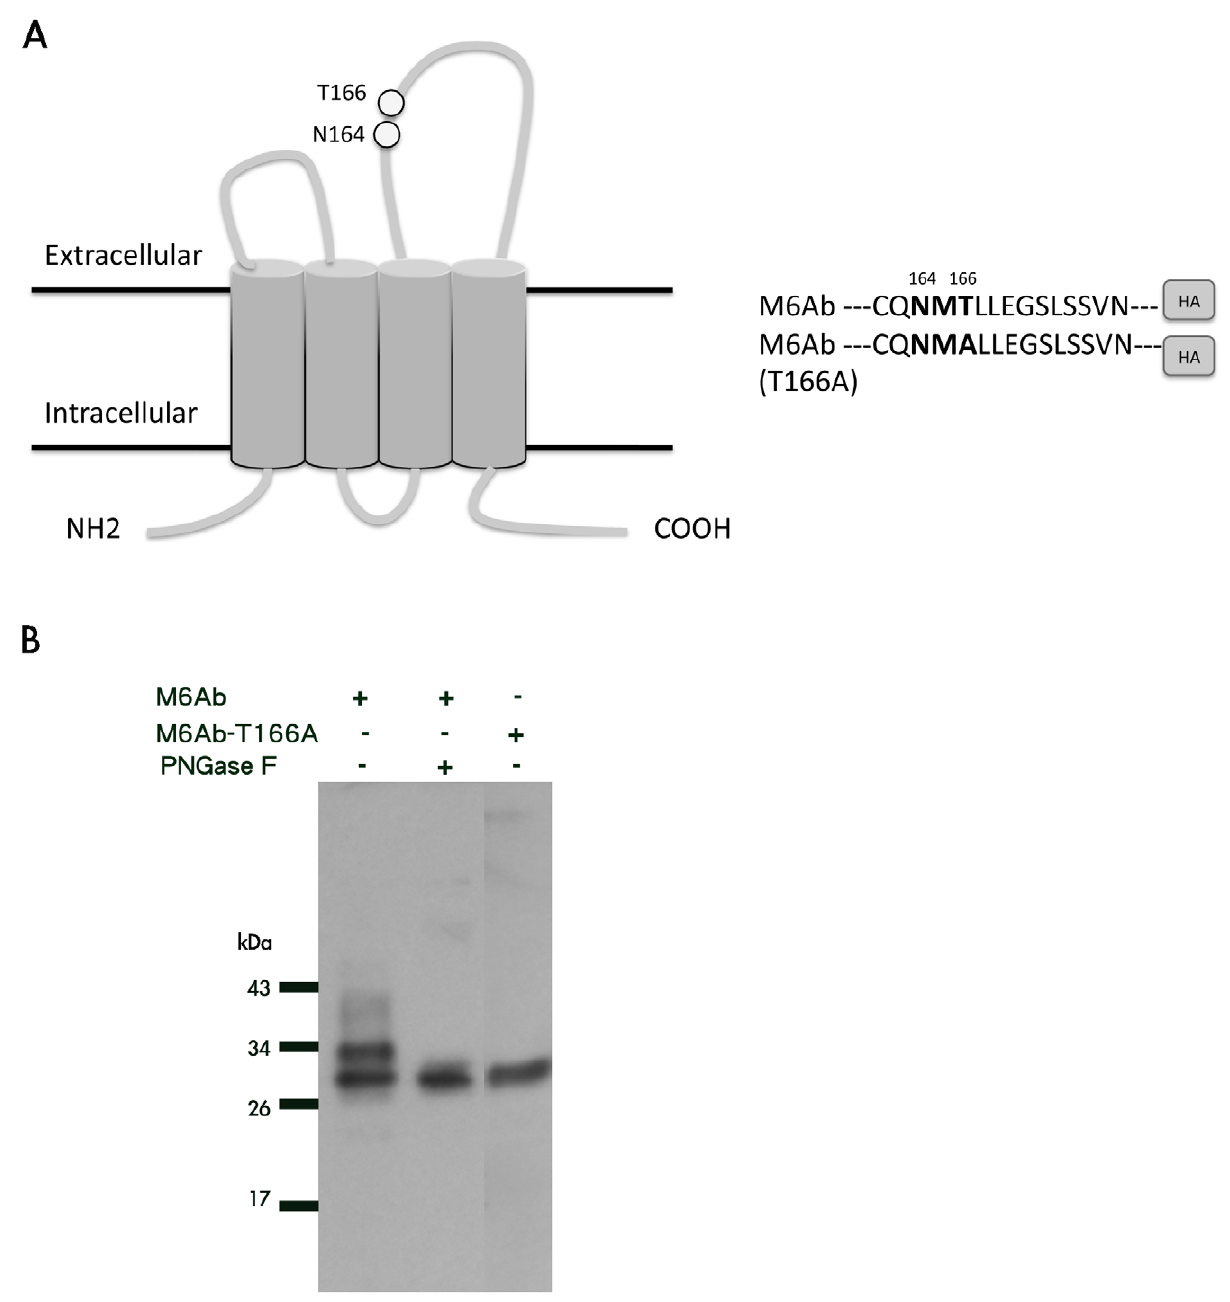
Figure 1. Zebrafish M6Ab is an N-linked glycoprotein. (A) M6Ab structural features. Based on the predicted computational model, zM6Ab contains four transmembrane domains [10]. The proposed N-glycosylation sites, NXT (164 , 166), are localized to the second extracellular domain. (B) COS-1 cells were transfected with the pcDNA3-M6Ab-HA and pcDNA3-M6Ab (T166A)-HA plasmids. Two days after transfection, cell lysates were treated with PNGase F for 18 h at 37 u C and then subjected to an SDS-PAGE and Western blot analysis using an anti-HA antibody.